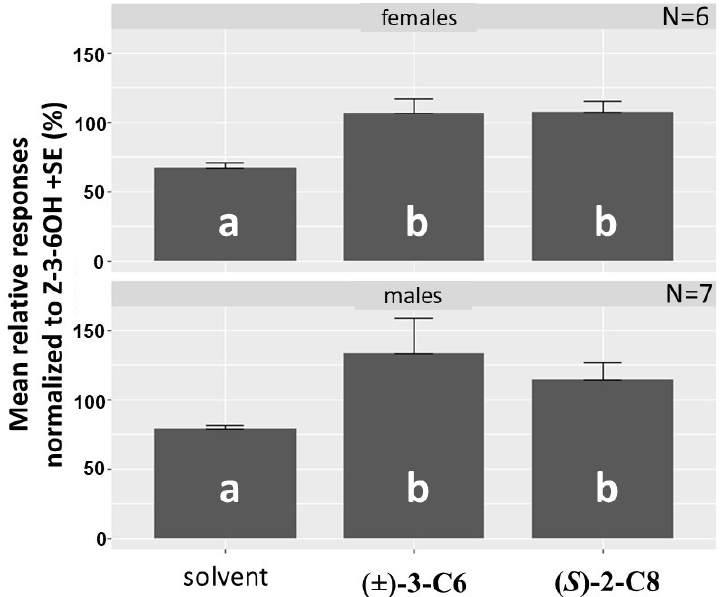
Figure 5. Normalized electroantennogram (EAG) responses of Clerus mutillarius to 100 ng doses of racemic 3-hydroxyhexan-2-one [( ± )-3-C6] and ( S )-2-hydroxyoctan-3-one [( S )-2-C8] expressed as means of seven males and six females. Means followed by the same letter are not significantly different, ANOVA and Fisher’s Protected LSD test ( P < 0.05). Responses were normalized to the response of ( Z )-3-hexenol (= 100%).